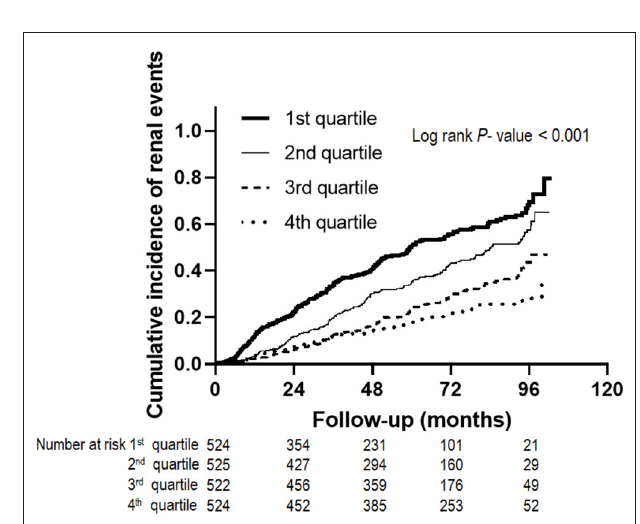
FIGURE 2 | Renal events according to Klotho/FGF23 ratio. The Kaplan-Meier curves show that the low Klotho/FGF23 ratio group had a significantly higher cumulative incidence of renal events ( P < 0.001). FGF23, fibroblast growth factor 23.